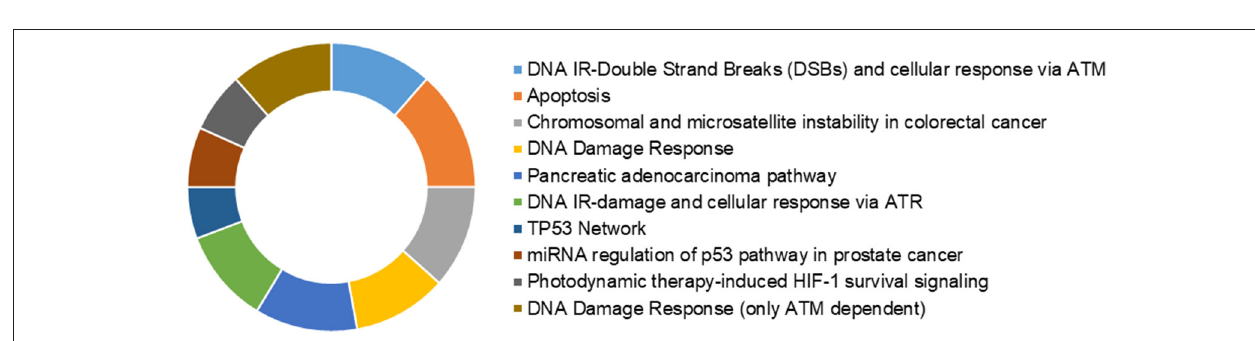
FIGURE 3 | Distribution of the over-represented cancer-related WikiPathways in the DEGs of each transcriptome dataset. The enriched pathways are indicated by gray.